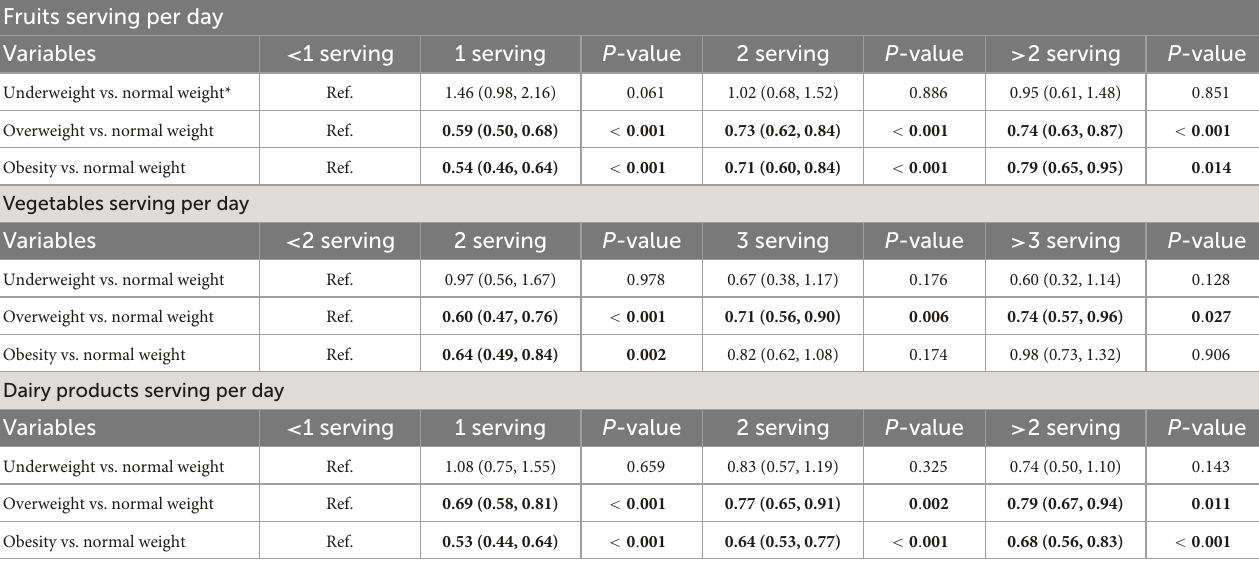
TABLE 3 Association between intake of fruits, vegetables and dairy products with body mass index (BMI) in the adjusted